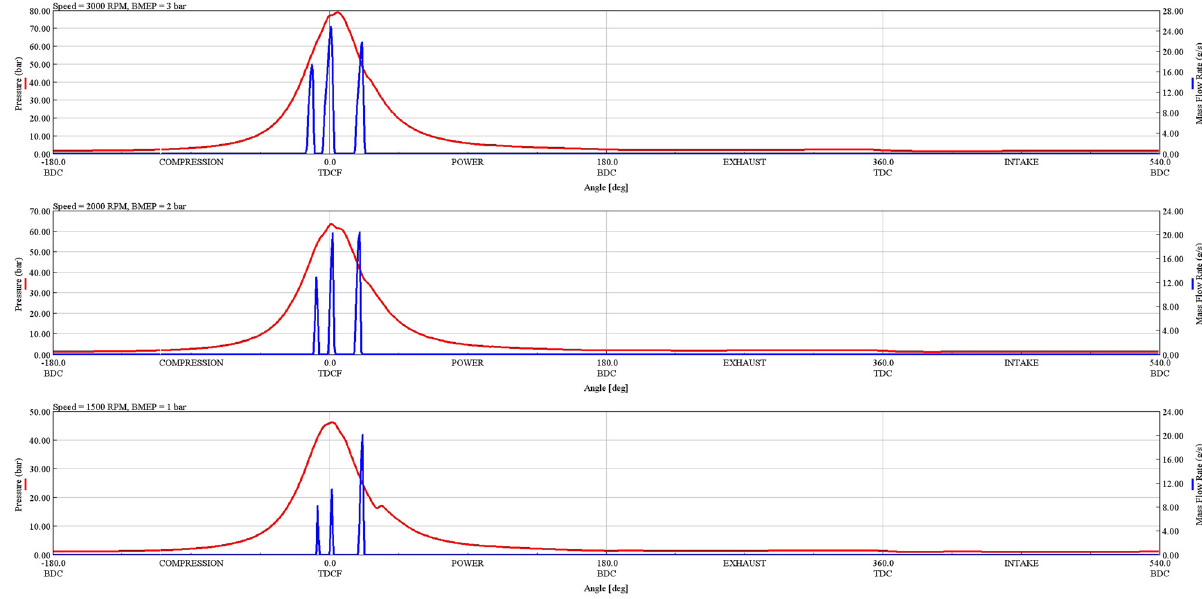
Figure 2: Cylinder pressure trace ( red ) with respect to injection pulses ( blue ) .